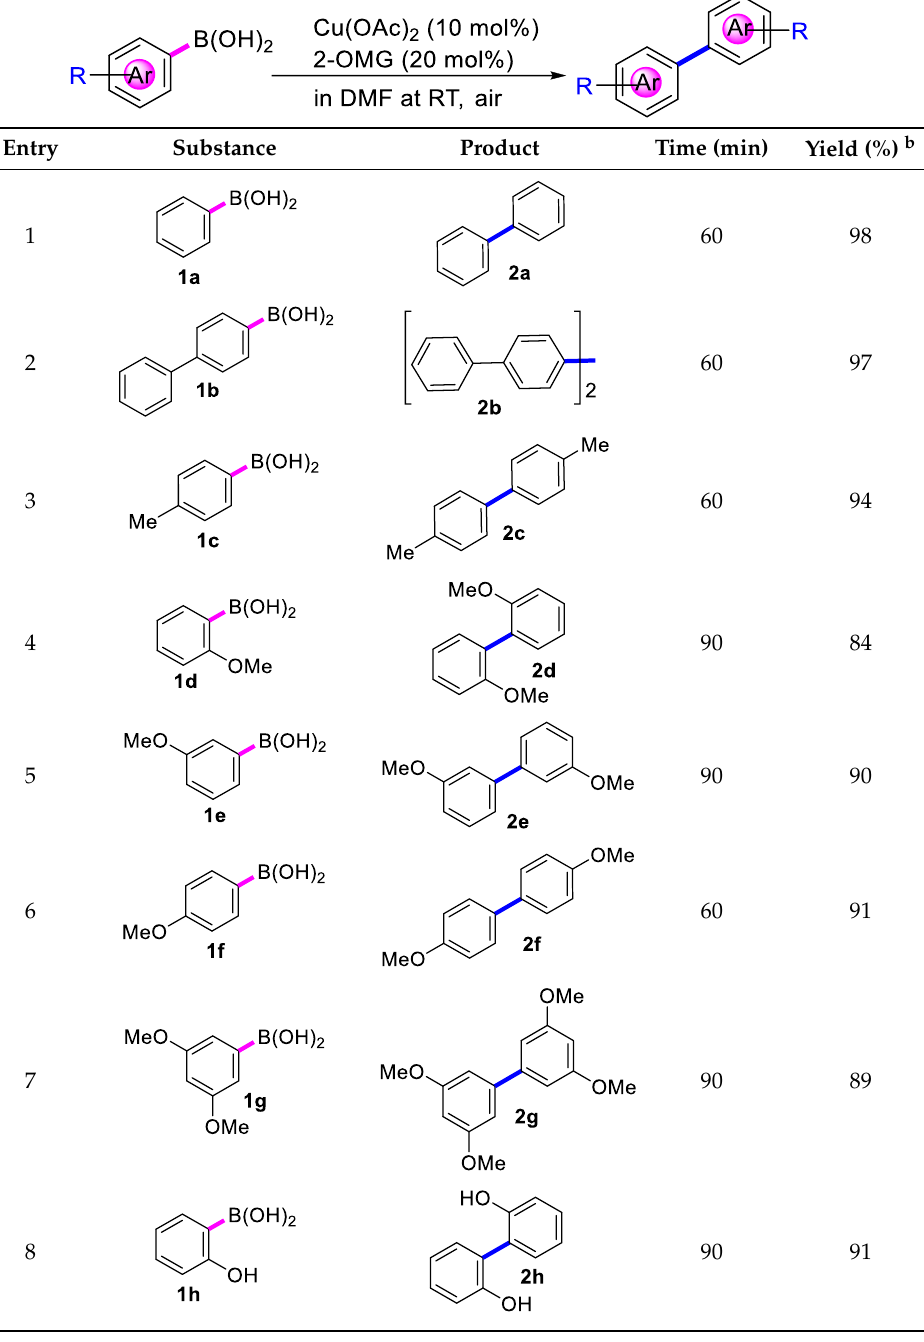
Table 2. Scope with respect to (hetero)arylboronic acids a .